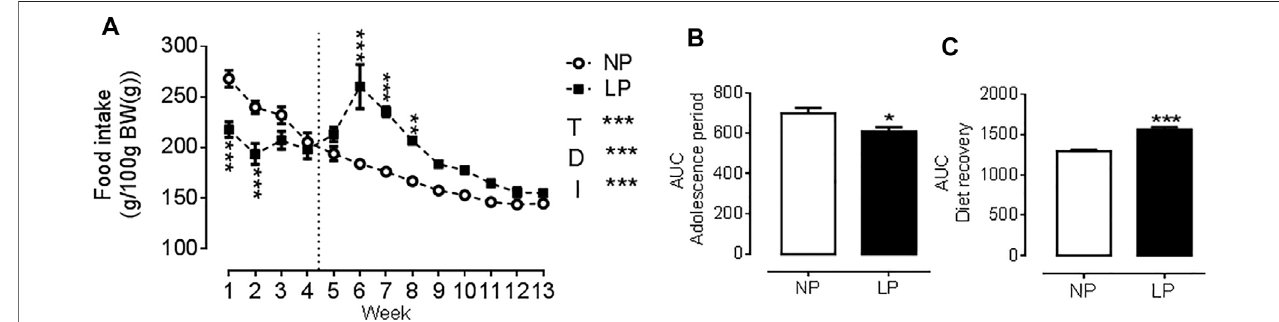
FIGURE 1 | Food consumption throughout the experimental protocol. Food consumption (A) , Area under the curve of food consumption during the peri-pubertal period (B) , Area under the curve of food consumption during the dietary recovery period (C) , n = 18 animals per group. NP, normal protein diet; LP, low protein diet; I, interaction between diet and time, AUC, area under the curve. Values presented as mean ± SD. *** p < 0.001, ** p < 0.01, and * p < 0.05 indicate statistical signi fi cance (Two-way ANOVA or Student ’ s T test).